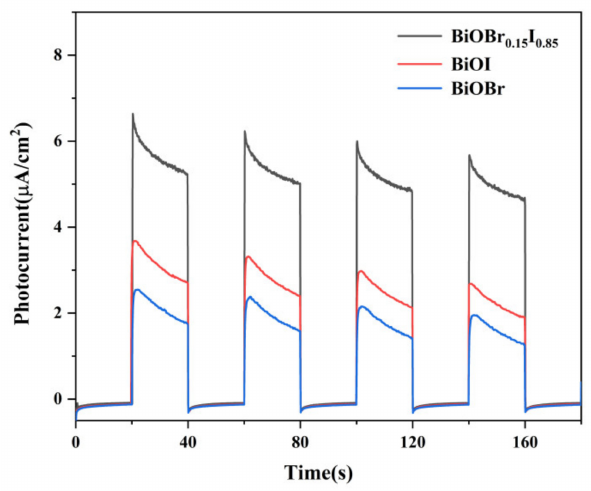
Figure 12. Photocurrent responses of the BiOBr, BiOI, and BiOBr 0.15 I 0.85 in 0.5 M Na 2 SO 4 aqueous solutions vs.